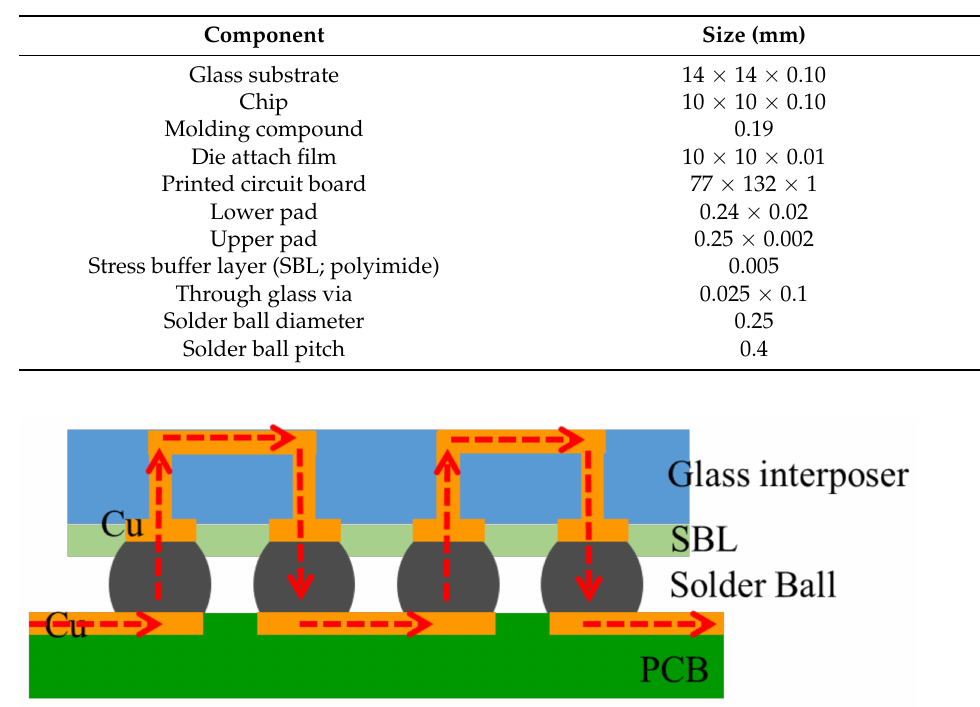
Figure 2. ( a ) Fan-out wafer-level package (FO-WLP) after debonding; ( b ) schematic of the fabricated FO-WLP onboard. Table 1. Dimensions of the components in a fan-out wafer-level package (FO-WLP).